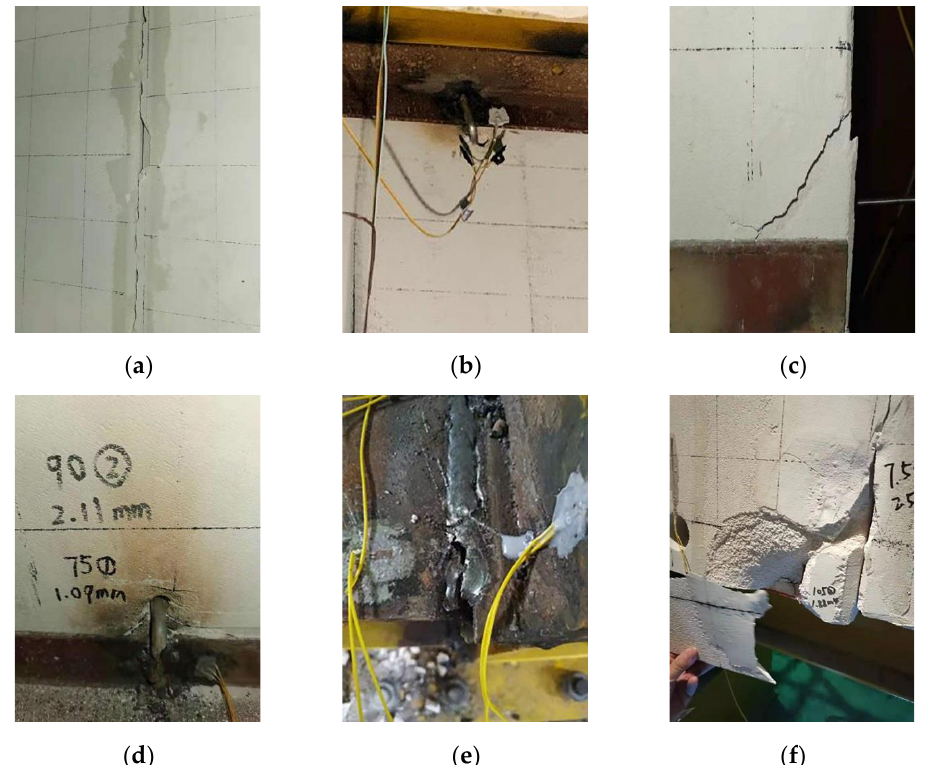
Figure 6. Phenomena during the test of JD-1. ( a ) Destruction of jointing mortar; ( b ) loosed L-hooked bolt; ( c ) crushing at the panel corner; ( d ) cracks at L-hooked bolt hole; ( e ) weld fracture; ( f ) spalling of ALC panels.